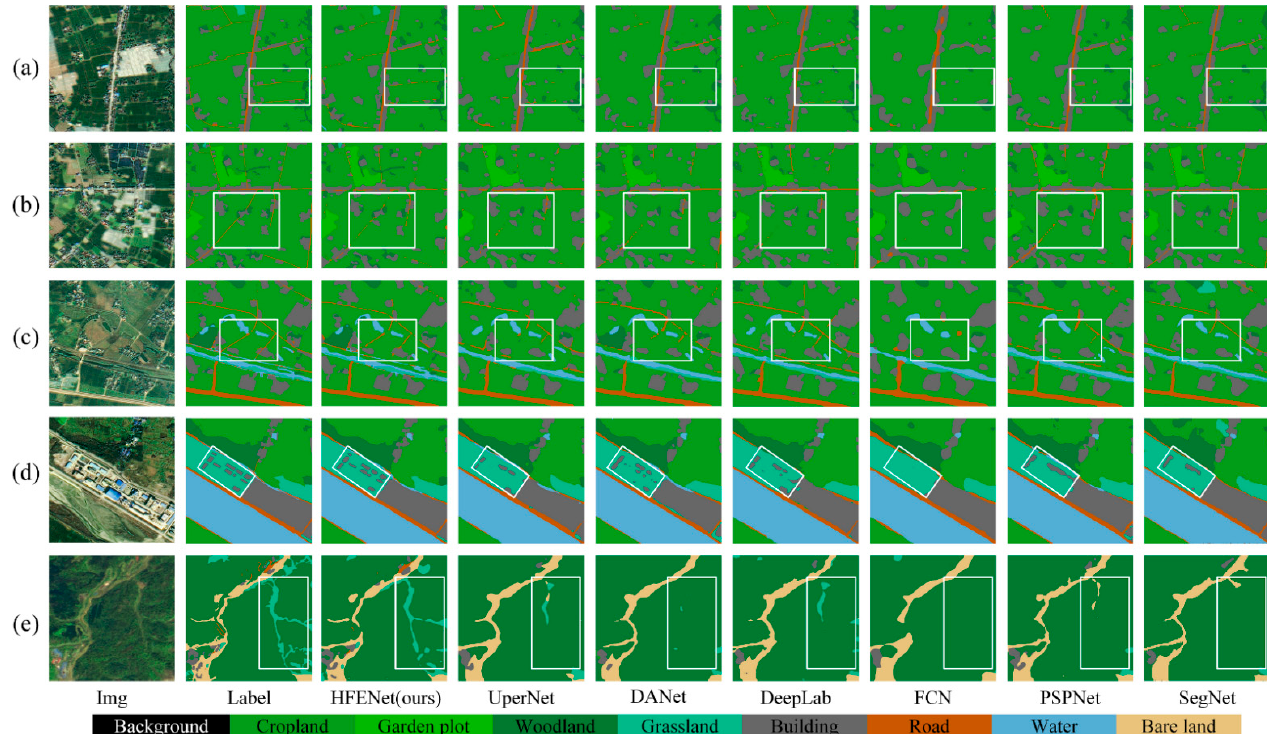
Figure 9. Visualization comparison of classification results of different state-of-the-art models on the MZData. ( a – d ) shows the typical case that it is difficult to identify roads and buildings in small-scale features. ( e ) shows the complex scenes where woodland and grassland are easily confused.